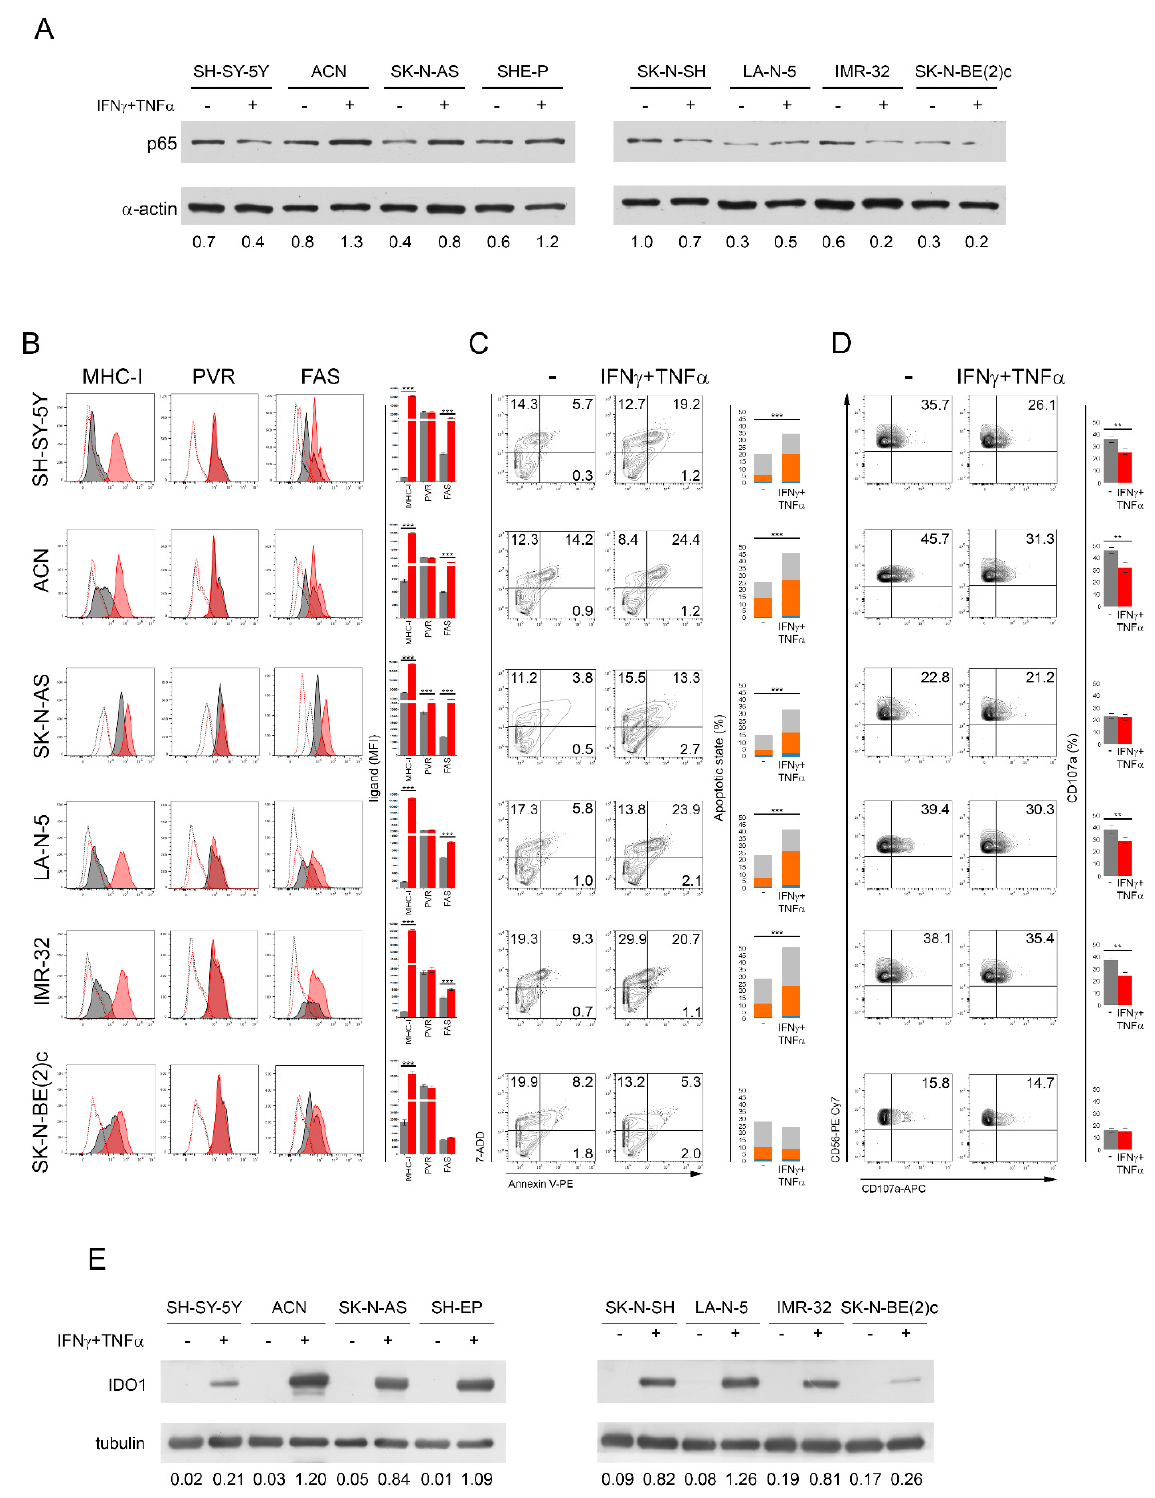
Figure 3. The treatment of NB cell lines with IFN γ and TNF α modulates p65 and increases Fas, thus rendering NB cells more susceptible to NK-cell-mediated apoptosis but not to NK cell degranulation. ( A ) NB cell lines were treated with IFN γ and TNF α for 48 h and analyzed for the expression of p65 by Western blotting. A representative of two independent experiments is reported. Below each panel, the normalized densitometry measured by ImageJ analysis is reported. ( B ) IFN γ and TNF α -treated NB cell lines were evaluated for the surface expression of MHC class I, PVR, and Fas by flow cytometry, together with the other ligands shown in Figure S4A. Isotype-matched negative control antibodies are displayed as dashed gray and red lines for untreated and cytokine-treated NB cell lines, respectively. A representative experiment out of the